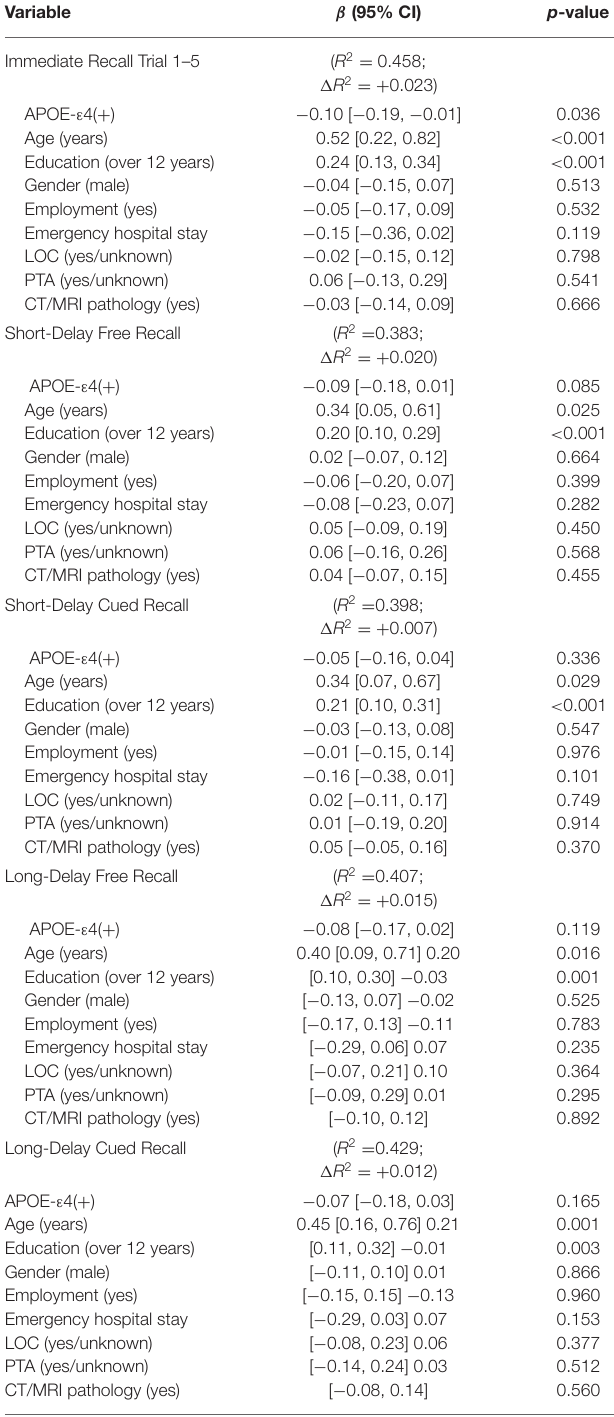
TABLE 2 | Multivariable regression analyses of APOE- ε 4 genotype and verbal memory subscales (California Verbal Learning Test-II) at two months